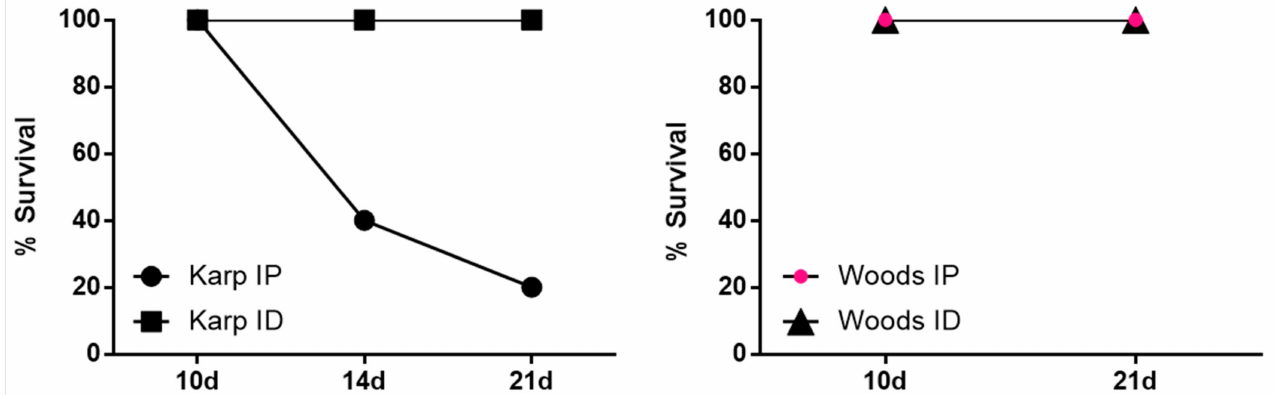
Figure 1. Comparison of survival in lethal and nonlethal murine models of O. tsutsugamushi infection, based upon strain and challenge route. All animals challenged with strain Woods (intraperitoneally (IP) or intradermally (ID)) and with strain Karp (ID) survived. Animals challenged with strain Karp (IP) demonstrated 40% and 20% survival at 14 dpi and 21 dpi,